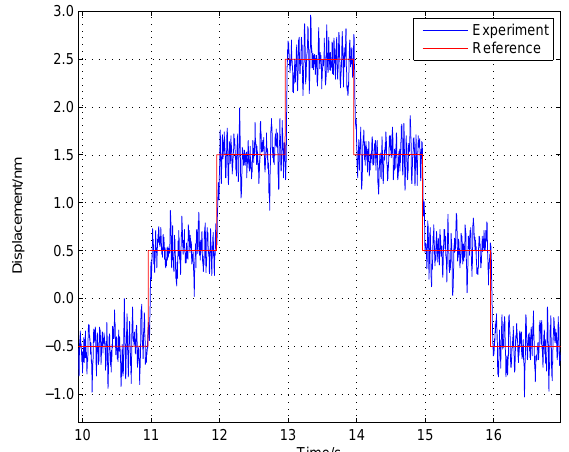
Figure 4. Positioning resolution of the micropositioning